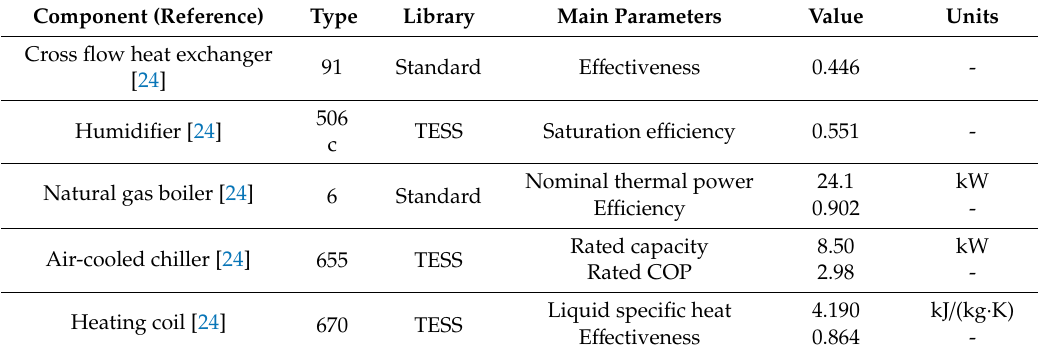
Table 2. Main TRNSYS submodels considered for the simulation and their main